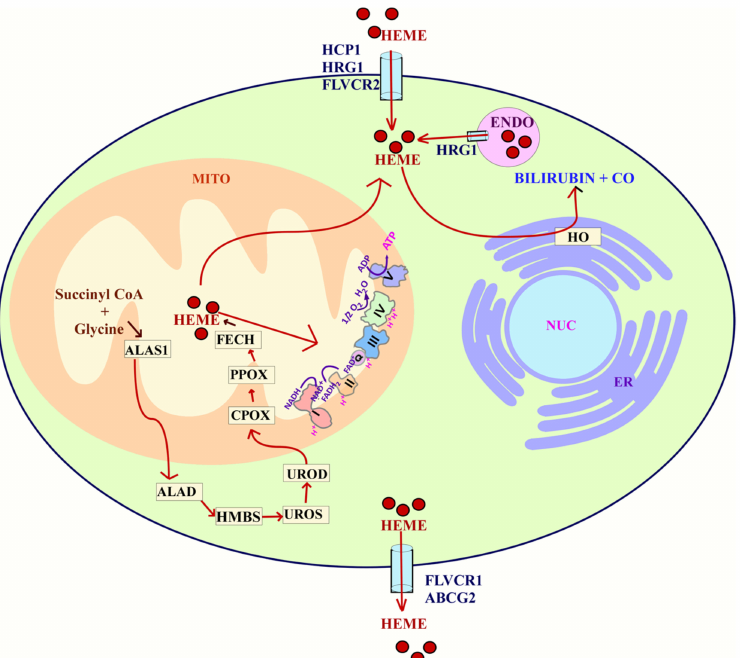
Figure 3. Heme flux. The uptake of heme is mediated by HCP1, HRG1, and FLVCR2. Heme can also be synthesized through an 8 enzyme step reaction that is carried out both in the cytoplasm and mitochondria. Heme acquired either by uptake or synthesis can be utilized for complexes in the ETC. Heme can also be degraded into bilirubin and carbon monoxide (CO) in a process that involves HO. Finally, the export of heme is carried out by FLVCR1 or ABCG2. Abbreviations: heme carrier protein 1 (HCP1), ferrochelatase (FECH), coproporphyrinogen-III oxidase (CPOX), uroporphyrinogen III decarboxylase (UROD), uroporphyrinogen III synthase (UROS), hydroxymethylbilane synthase (HMBS), delta-aminolevulinic acid dehydratase (ALAD), Delta-aminolevulinate synthase 1 (ALAS1), feline leukemia virus subgroup C receptor-related protein 1 (FLVCR1), ATP-binding cassette super- family G member 2 (ABCG2), nucleus (NUC), endoplasmic reticulum (ER), endosome (ENDO), Feline leukemia virus subgroup C cellular receptor family, member 2 (FLVCR2), heme oxygenase (HO), mitochondria